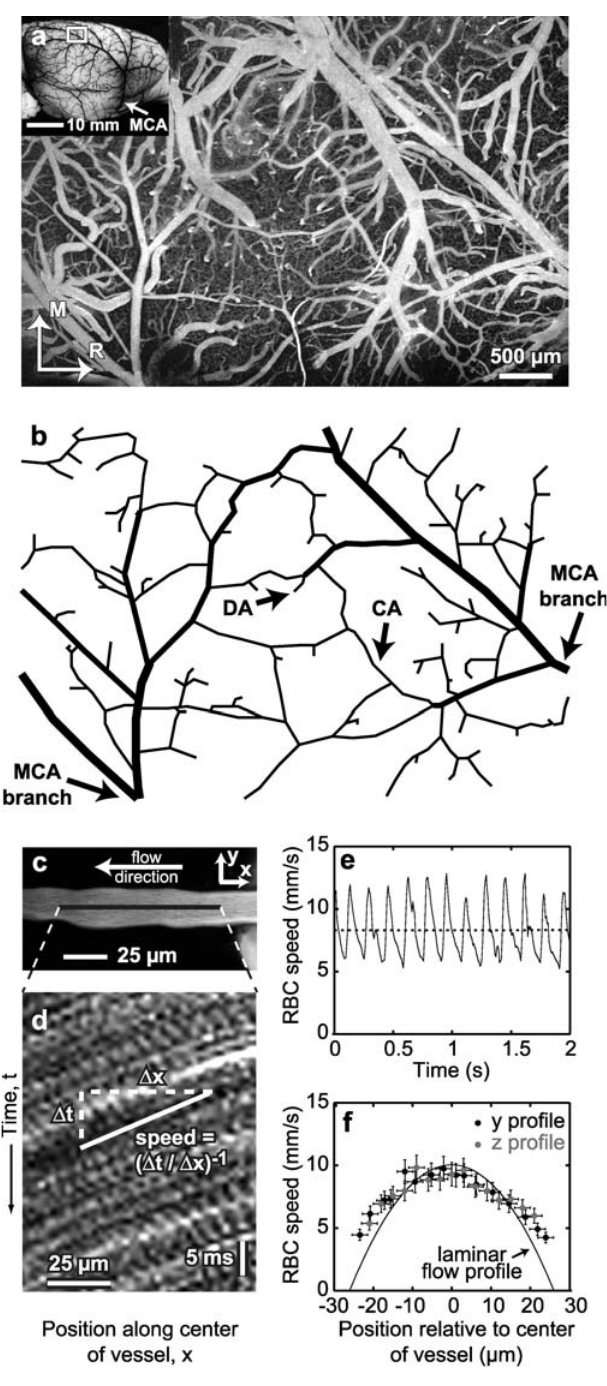
Figure 1. TPLSM of Fluorescently Labeled Cortical Vasculature In Vivo (A) Low-magnification TPLSM image of fluorescently labeled brain vasculature in rat parietal cortex. The axes indicate the rostral (R) and medial (M) directions. In the inset is an image of latex-filled brain vasculature taken from Scremin [1], with a box that indicates the approximate size and location of a typical craniotomy and an arrow that identifies the MCA. (B) Tracing of the surface arterial vascular network from the image in (A). Branches of the MCA are indicated, as are representative examples of the communicating arterioles (CA) that form the surface network and diving arterioles (DA) that supply cortex. (C) Maximal projection of a TPLSM image stack through a cortical arteriole. The dark line indicates the location where the line-scan